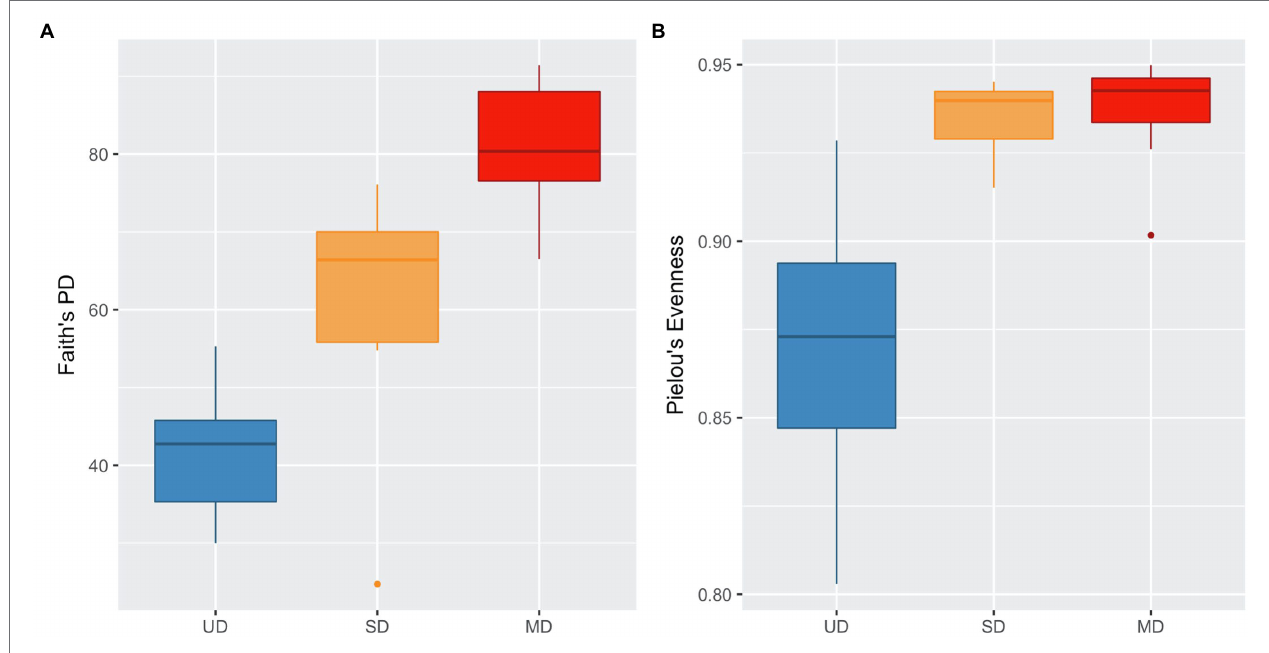
FIGURE 1 | Boxplots of (A) Faith’s Phylogenetic Diversity and (B) Pielou’s Evenness.